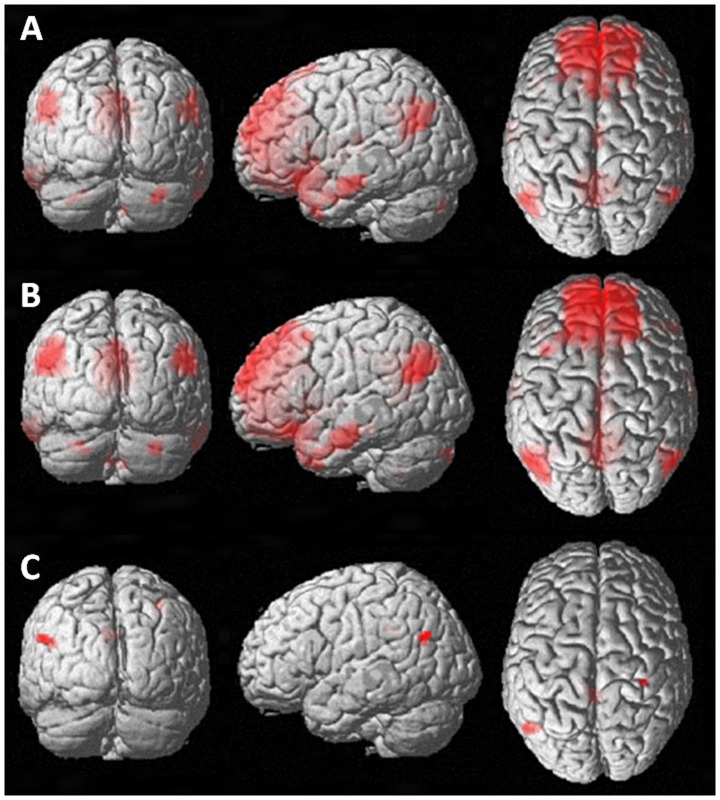
Functional connectivity (FC) in relation to the anterior cingulate cortex (ACC) in healthy controls (A) and MS patients (B) in periods of relative rest.MS patients (compared to controls) demonstrated increased FC to the right postcentral gyrus, the left angular gyrus and the left posterior cingulated cortex (C) (Images shown in coronal, sagittal, and axial orientation in neurological convention).